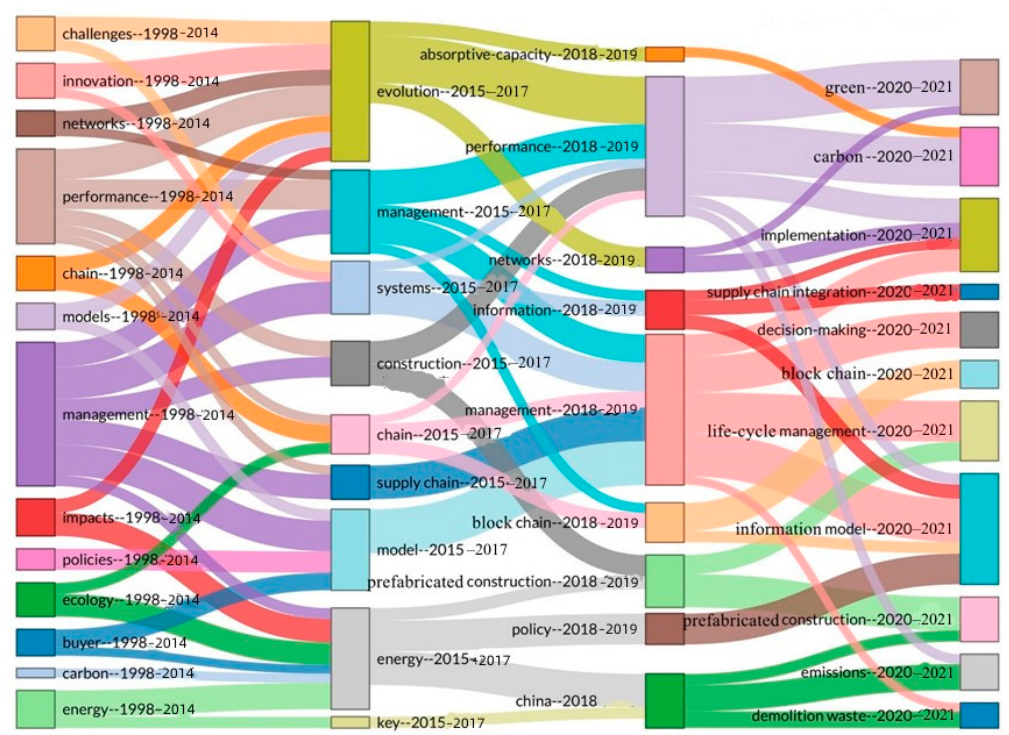
Figure 13. Thematic evolution of CSCM research (1998–2021)